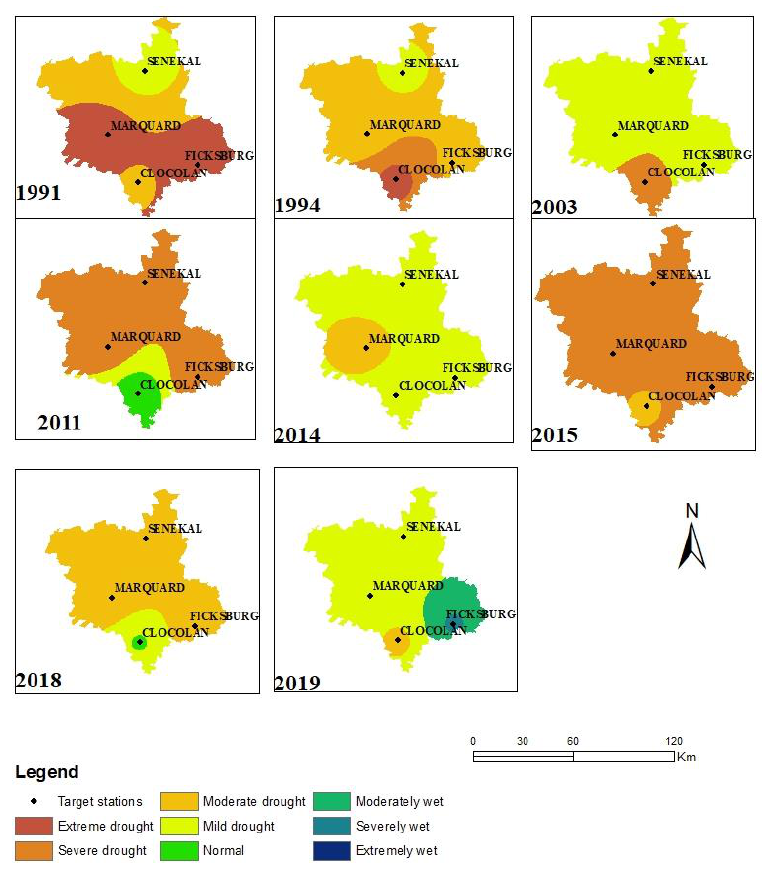
Figure 7. RDI-12 spatial-temporal pattern of drought in Setsoto municipality (1985–2019).